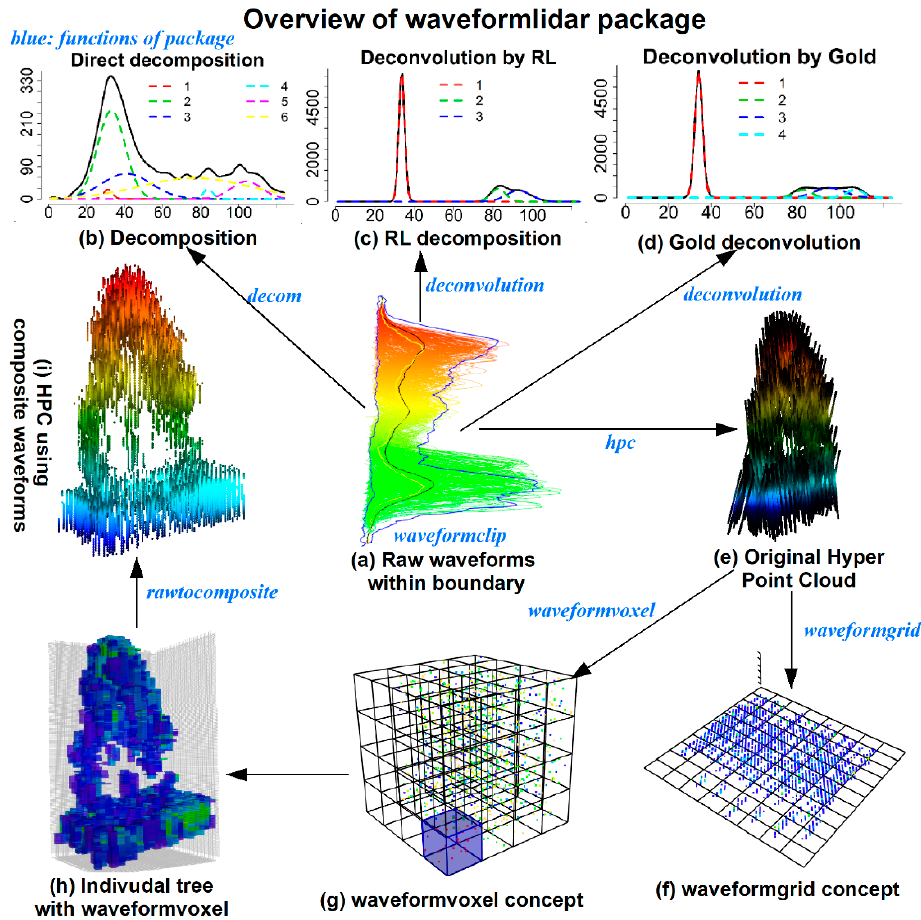
Figure 1. An overview of core functions for waveformlidar package.